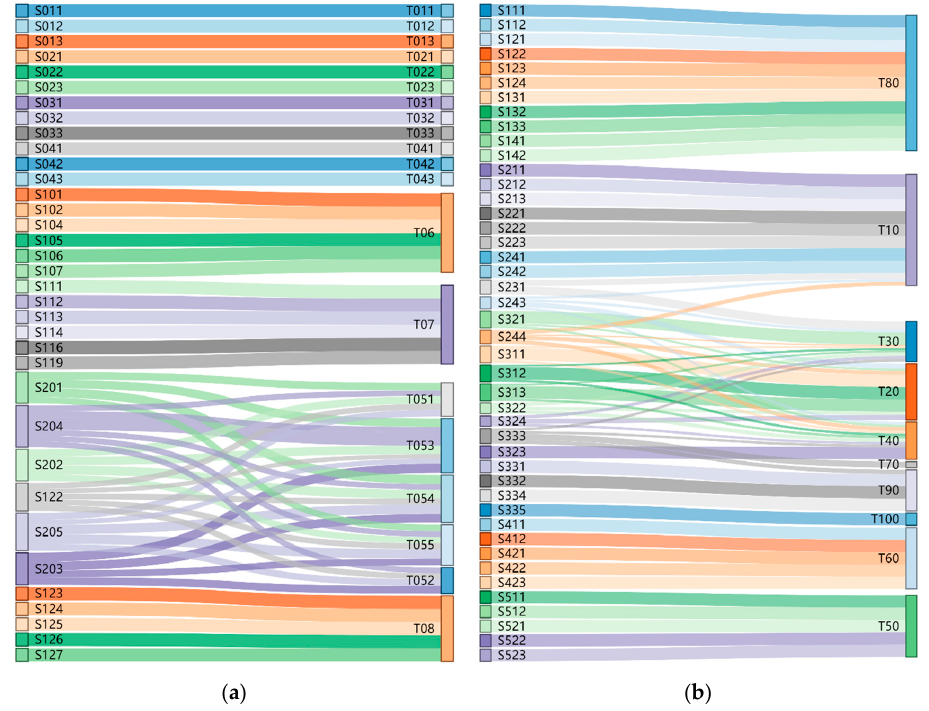
Figure 5. Sankey diagram showing the semantic translation probability ( a ) from NLS to PWSCS, and ( b ) from CLC to GlobeLand30.